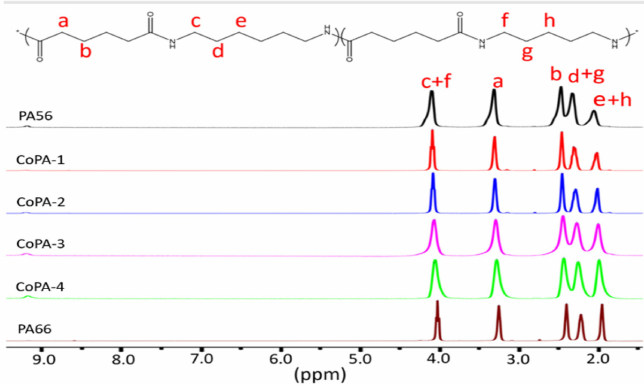
Figure 2. 1 H NMR spectra of PA56, PA66 and PA56/66